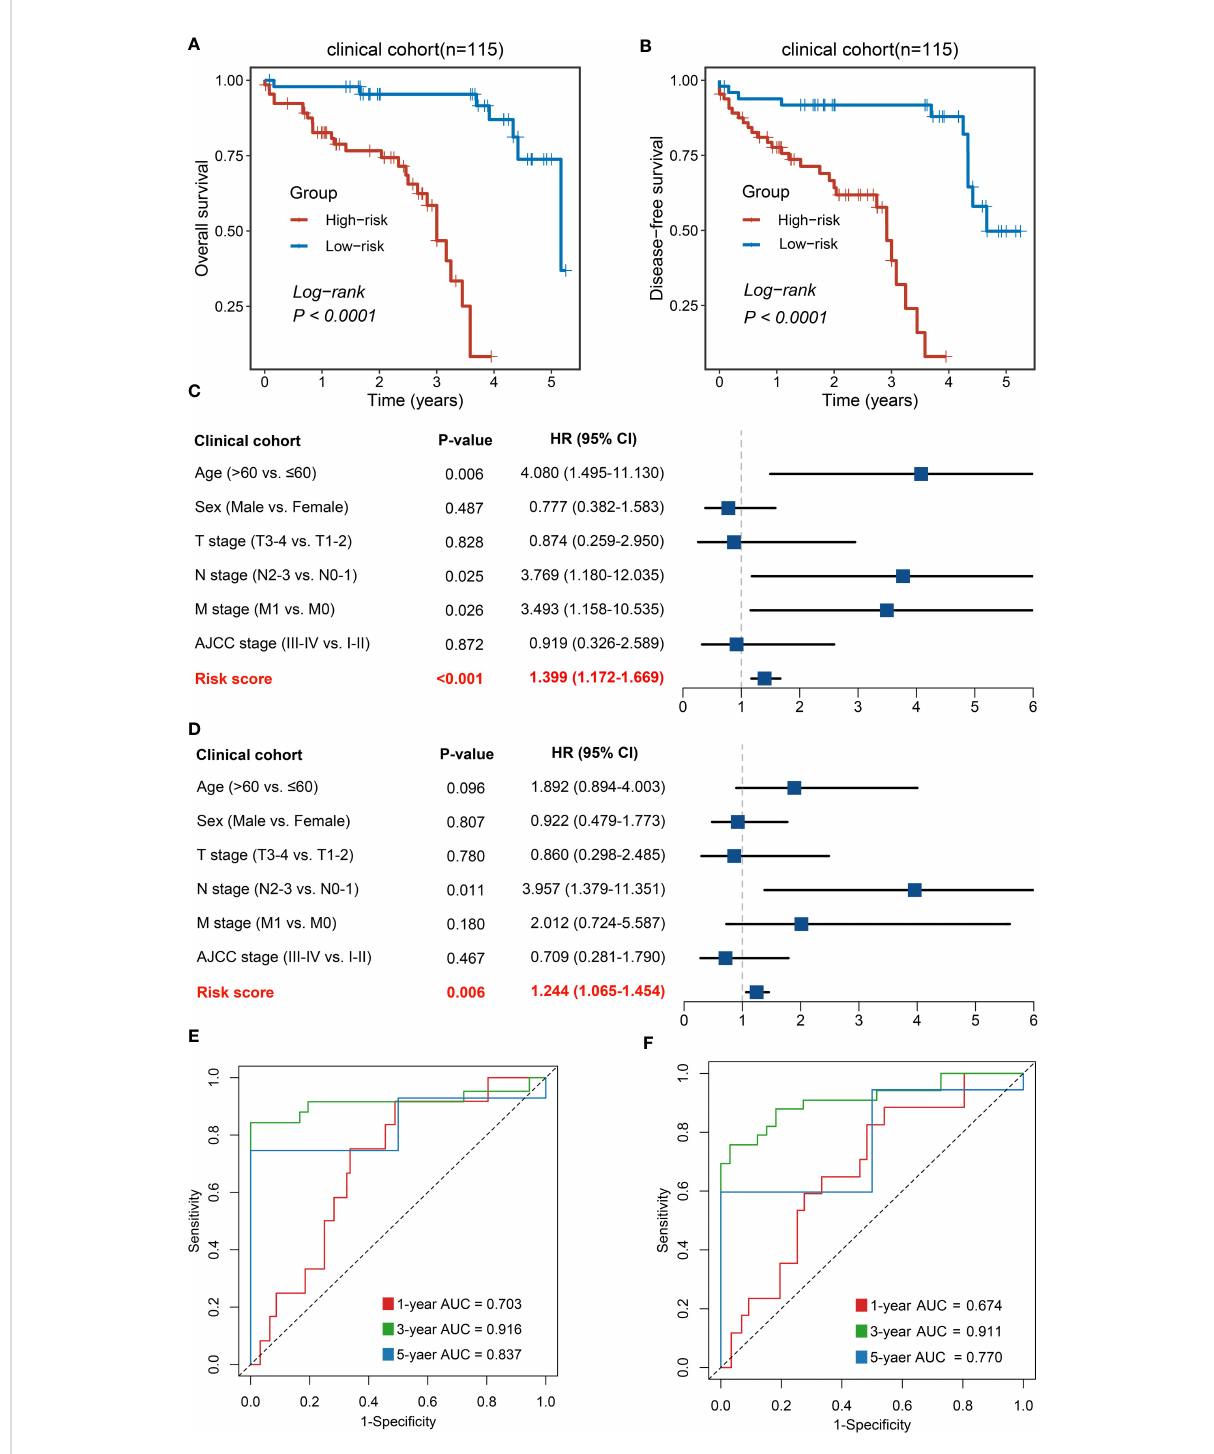
FIGURE 4 Validation of NLncS via qRT-PCR. (A, B) Kaplan – Meier curves of OS (A) and DFS (B) based on NLncS. (C, D) Multivariable Cox regression analysis of OS (C) and DFS (D). (E, F) Time-dependent ROC analysis for predicting OS (E) and DFS (F) at 1, 3, and 5